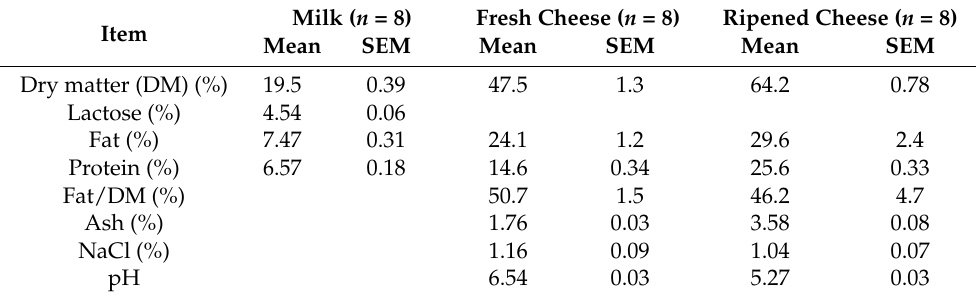
Table 2. Physicochemical composition of fresh and ripened Roja Mallorquina ewes’ cheese and corresponding original milk. Milk ( n = 8) Fresh Cheese ( n = 8) Ripened Cheese ( n = 8) Item Mean SEM